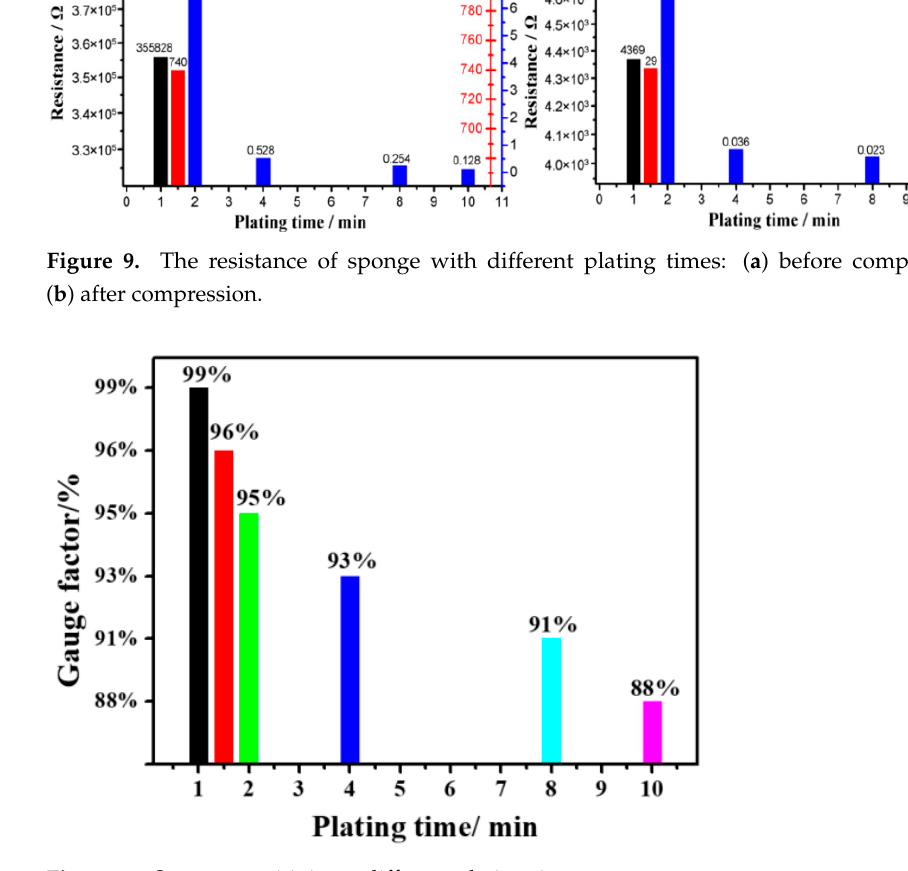
Table 1. Comparisons of the sensors’